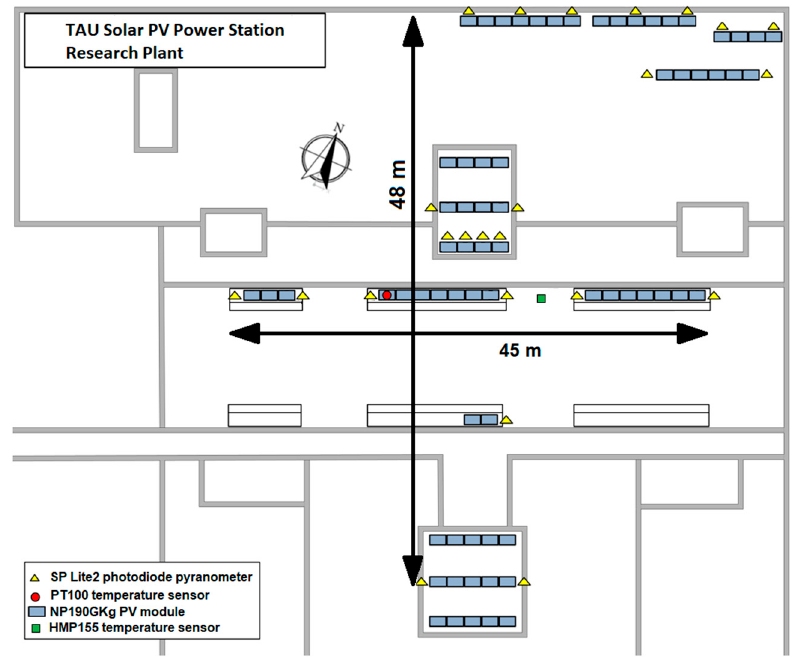
Figure 1. The dimensions of the PV generator and the locations of the PV panels (blue rectangles), pyranometers (yellow triangles), PV panel temperature sensor (red dot), and the ambient temperature sensor (green square) on the rooftop of Tampere University (TAU).